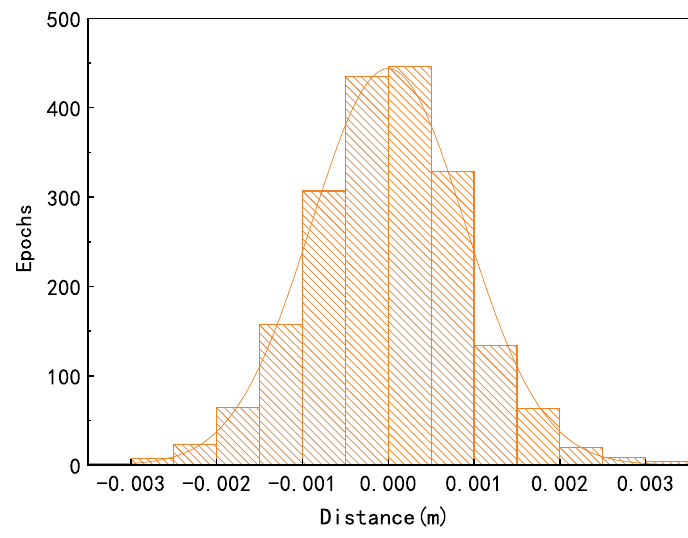
Figure 1. Normal distribution due to multipath and